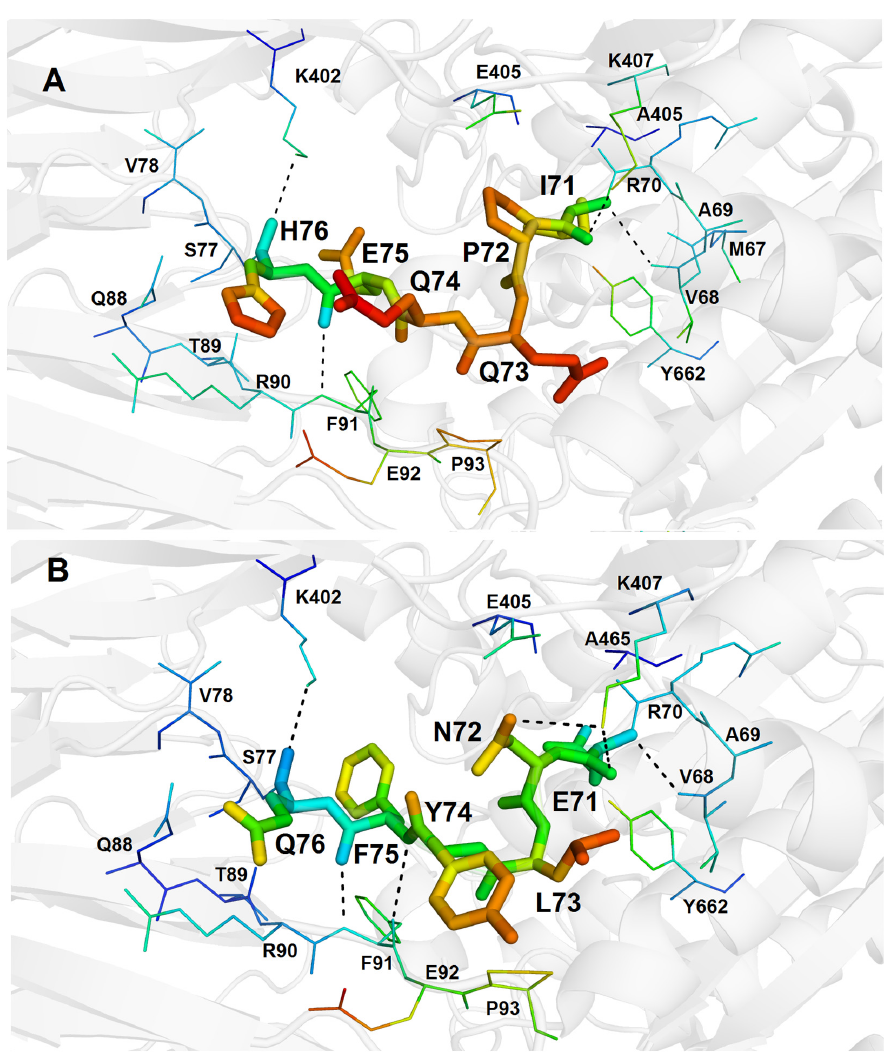
Figure 4. Comparison of the intact and modified hinge regions. ( A ) The amino acid surroundings in the 4 Å radius and polar contacts (dotted lines) of the intact hinge region in the SpOPBS532A structure (PDB ID 7ZJZ). ( B ) Similar representation of the modified hinge in the SpOPBmod structure (PDB ID 7YWS). All residues are shown in sticks and are colored according to the B-factor values. The residues from the first hinge peptide are